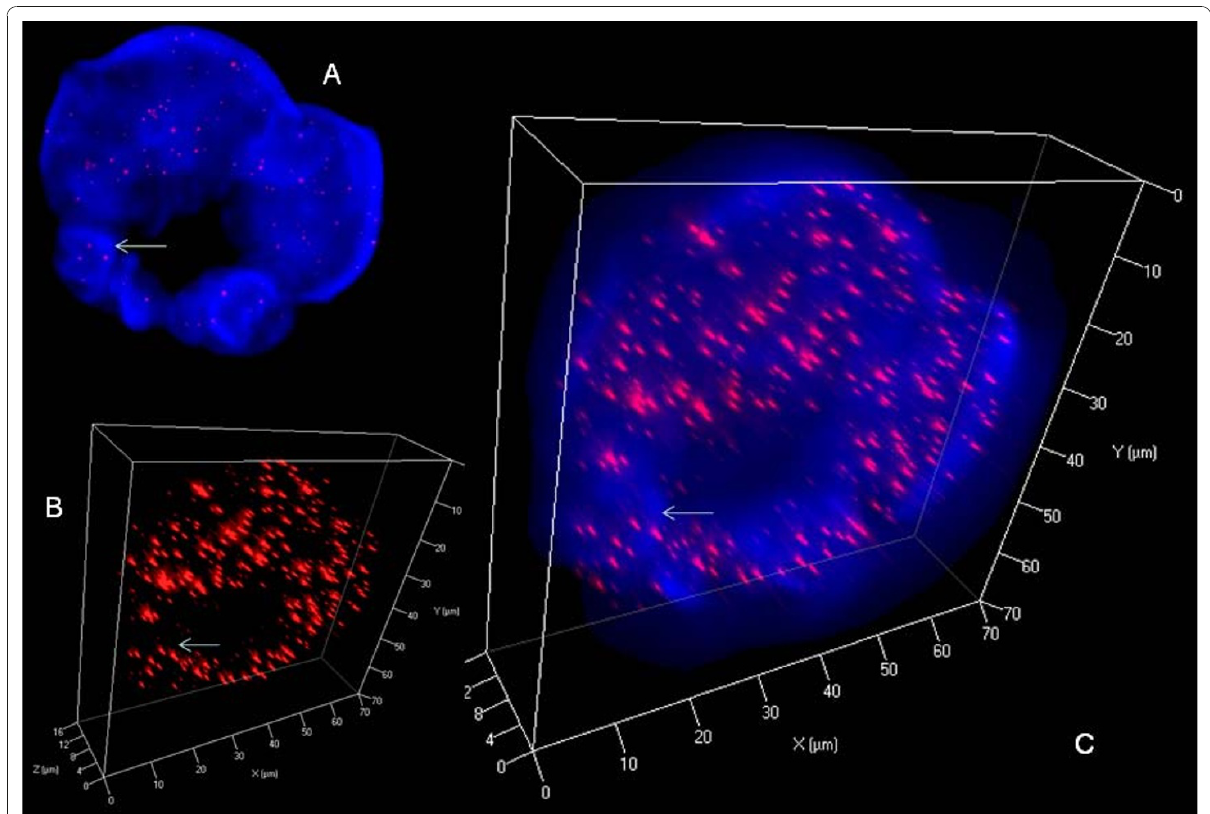
Figure 6 3D nuclear staining of telomeres and DNA in U-HO1 RS-cells . A. Representative 2D Z-stack image no. 36 out of 80 shows ring-like multinuclear (blue) RS-cell composed of at least four nuclei of variable size. Arrow identifies a telomere group also shown in B and C. B. 3D reconstruction in surface mode reveals abundant short and very short telomeres (red). C. Combined 3D nuclear staining confirms ring-like nuclear